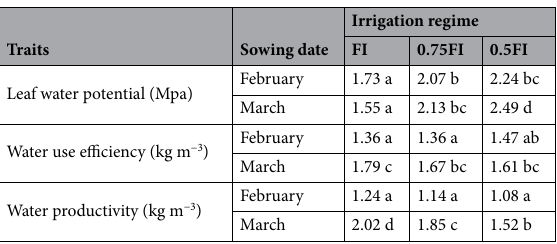
Table 5. The effects of irrigation regime and sowing date on water related traits in pea. FI, full irrigation. The data averaged on nitrogen and years. Means with different letters did differ significantly.